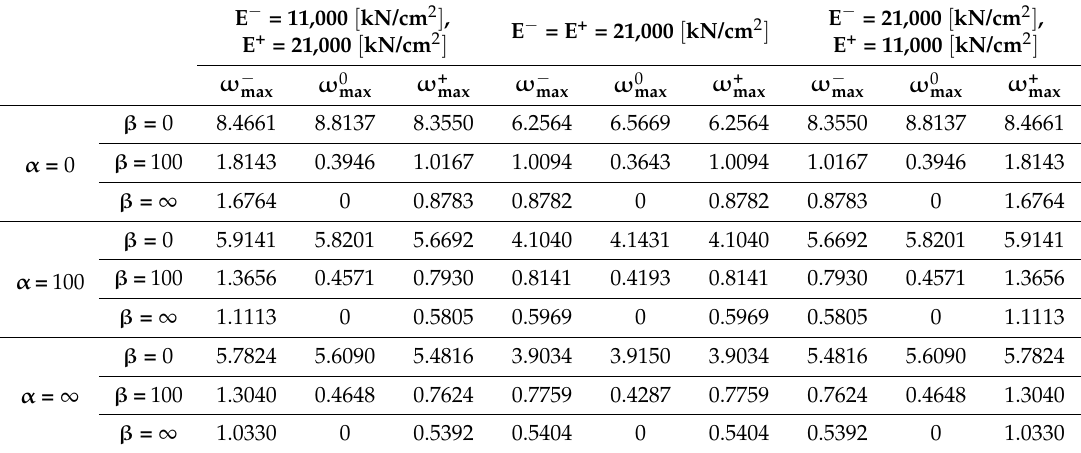
Table 3. The effect of modulus of elasticity E on maximal bending (cm) depending on the change of α and β in the plate system when the simply supported condition is given on the boundaries ( ν − = ν + = 0.3